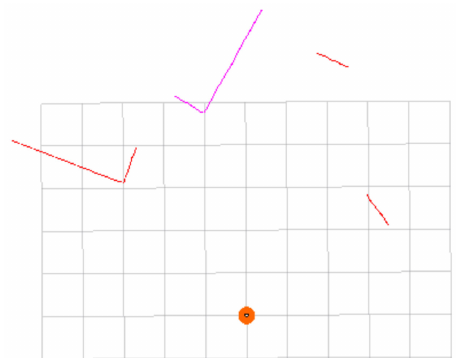
Figure 9. Clustering noise reduction results. The scan is clustered into 4 clusters, and the outlier is removed. Different lines represent different clusters. The color of lines has no special meaning, just to distinguish different clusters. Visualization using the MarkerArray plugin of